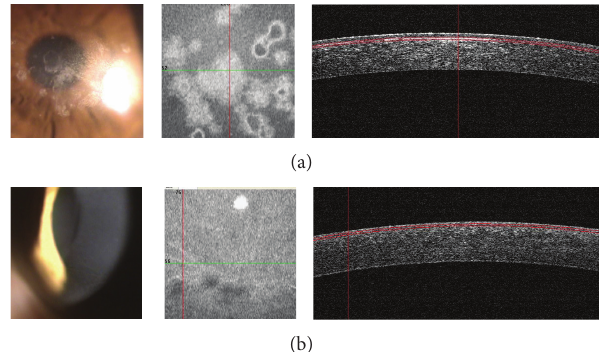
Figure 8: Anterior segment photography. En-face and horizontal OCTimagesofcornealdeposits.Granularcornealdystrophy(a)and corneal verticillata